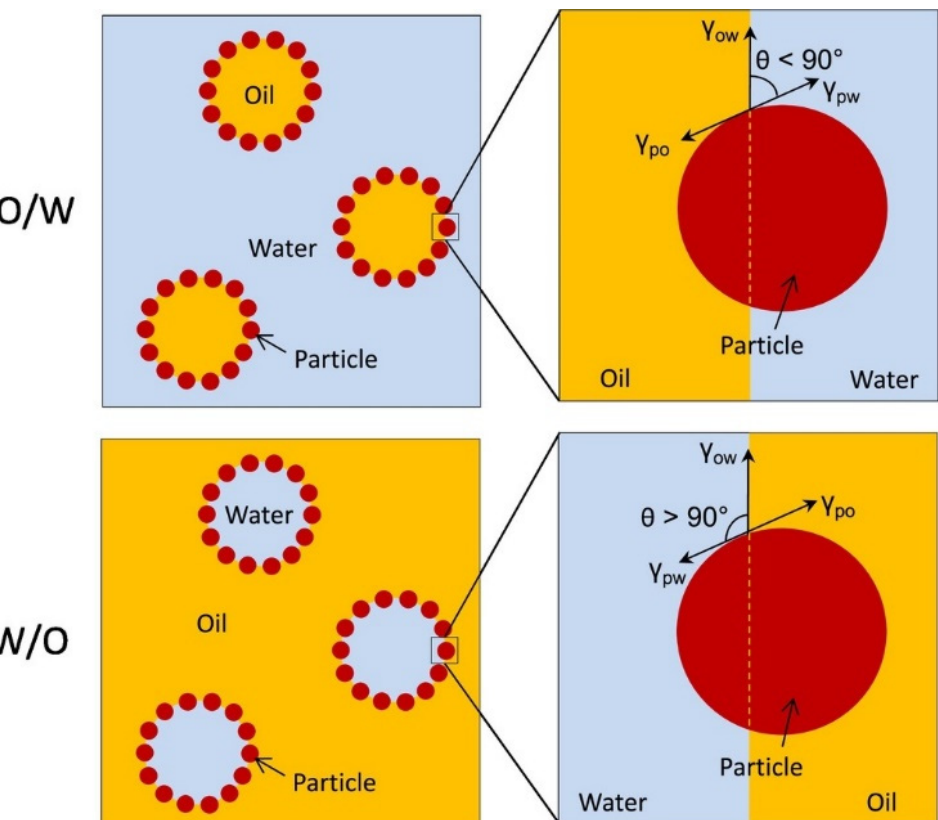
Figure 2. Sketch of the organization of the liquids and the particles in O/W and W/O Pickering emulsions ( left ) together with the geometrical definition of the three-phase contact angle ( θ ) for both types of emulsions as a function of the particle–oil ( γ po ), particle–water ( γ pw ) and oil–water ( γ ow ) interfacial tensions ( right ). Reprinted from Albert et al. [20], Copyright (2019), with permission from Elsevier.